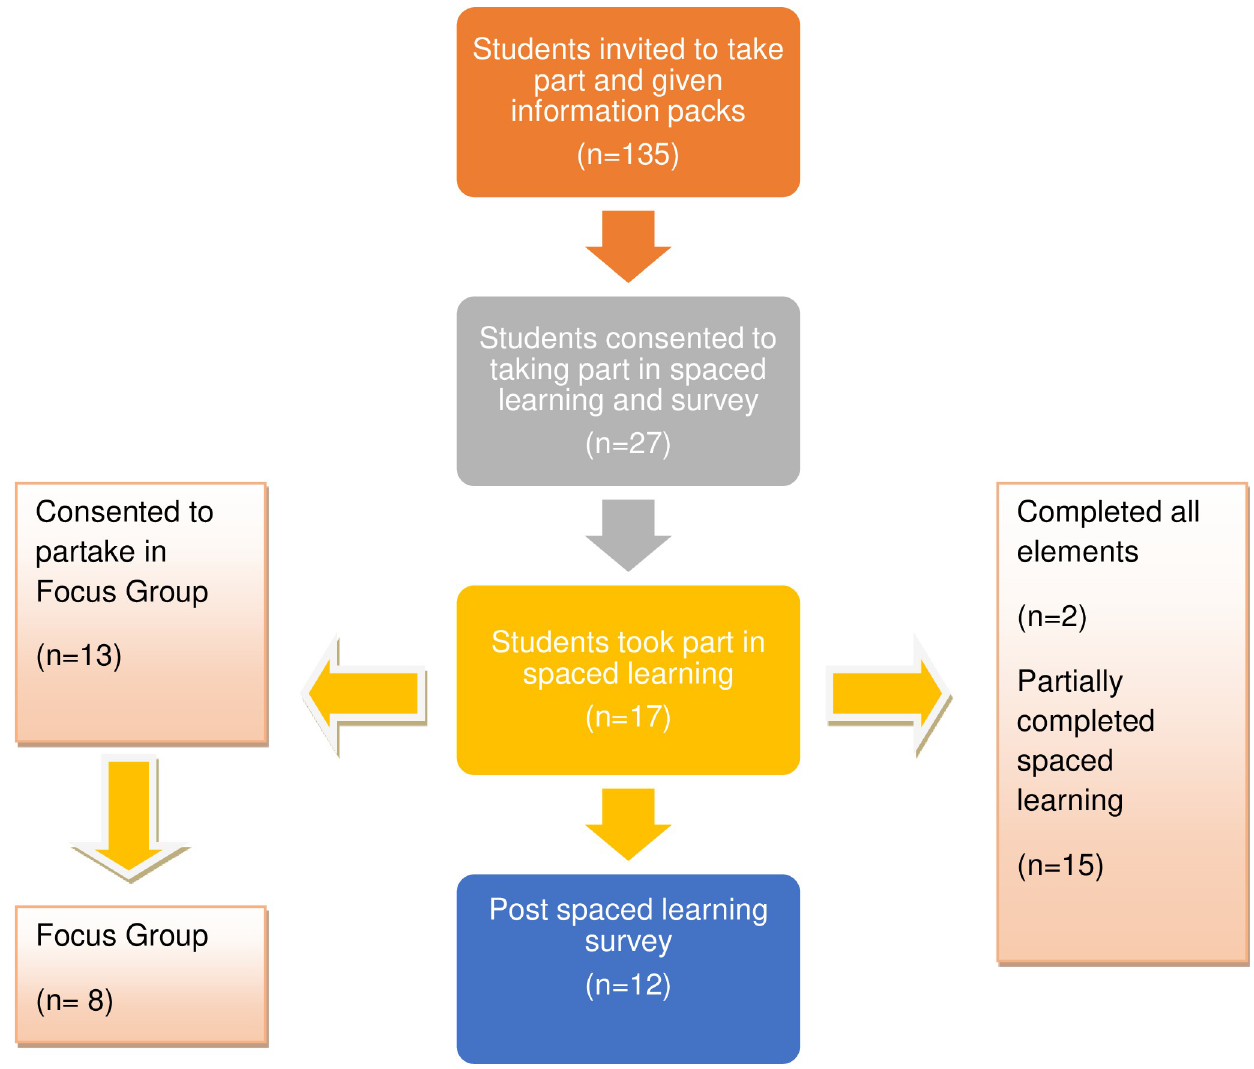
Fig 2. Study recruitment and